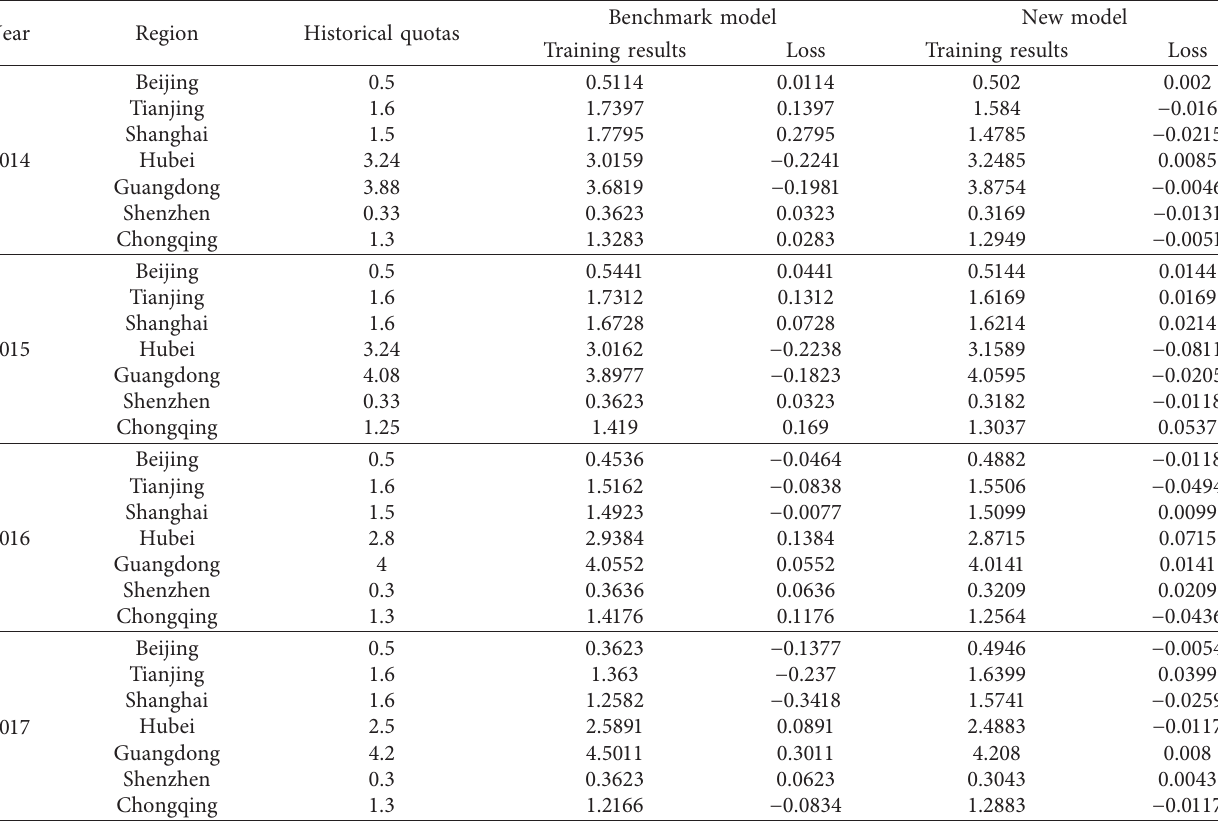
Table 8: Comparison between model results and historical quotas.